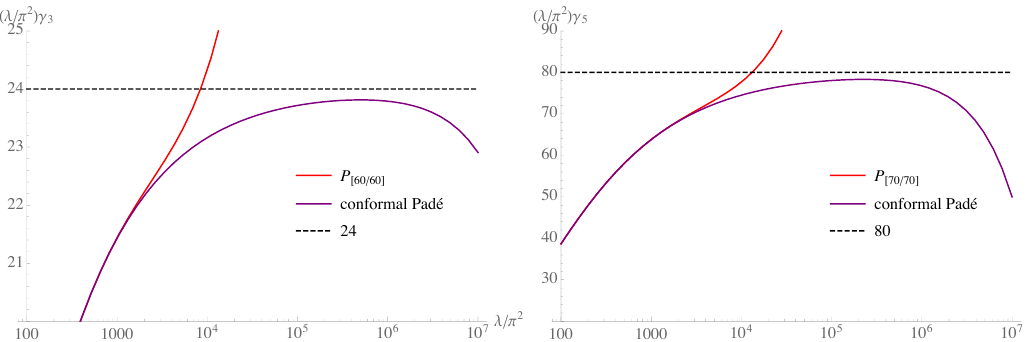
Figure 3 . Comparison between the simple and the conformally improved Padé approximants for ( λ/π 2 ) γ 3 (left) and ( λ/π 2 ) γ 5 (right). This quantity is expected to tend to 24 for γ 3 and to 80 for γ 5 .